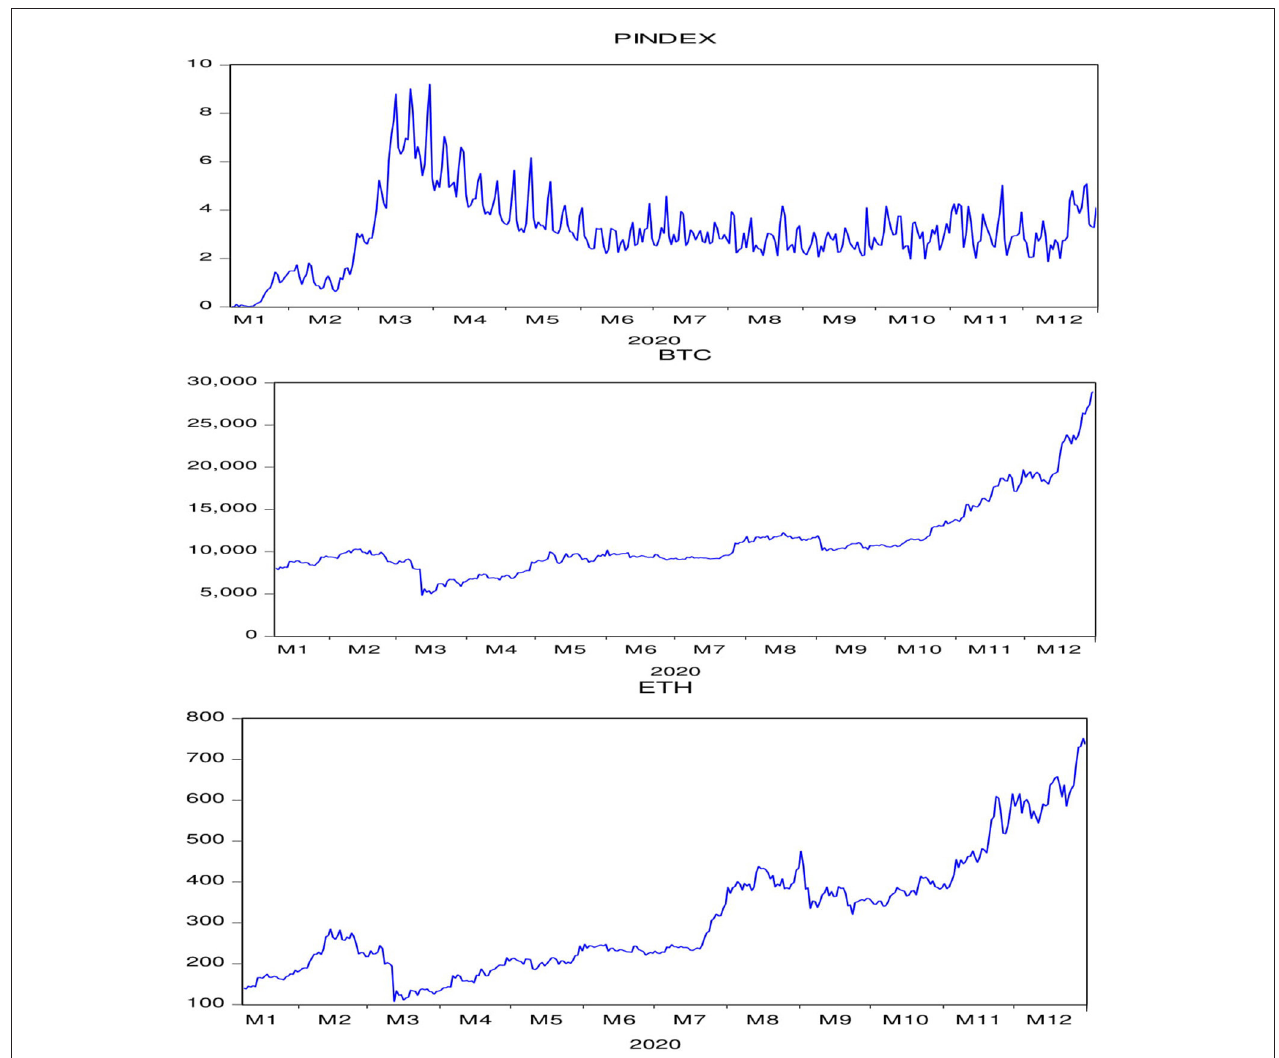
FIGURE 1 | Panic Index, Bitcoin, Ethereum, and Ripple Values Distribution